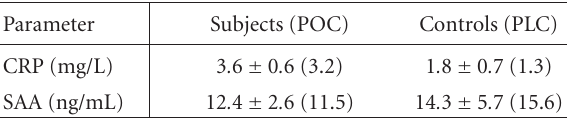
Table 2. CRP and SAA serum levels of the study participants. Data are expressed as means ± standard deviation